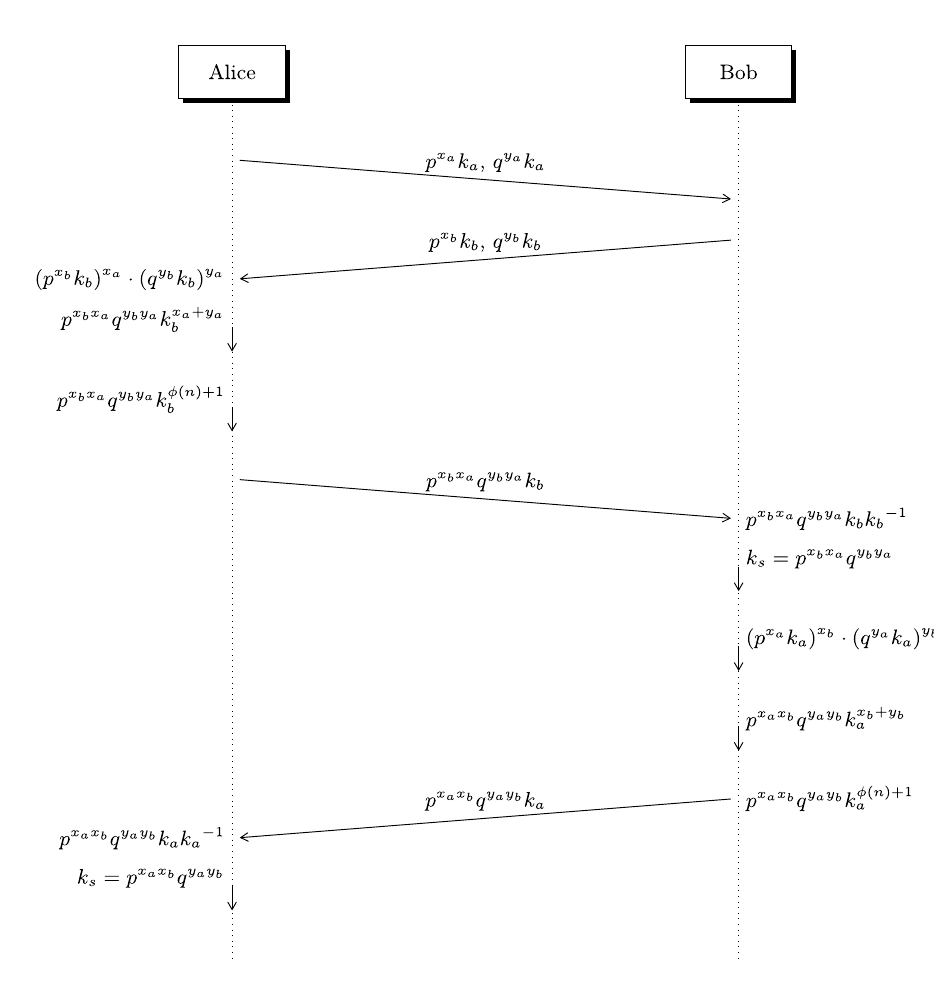
Table 7 The modulo n is computed as pqr , n and the prime numbers p , q and r are publicly known. The private key is ( x , k i ) where i = a ,